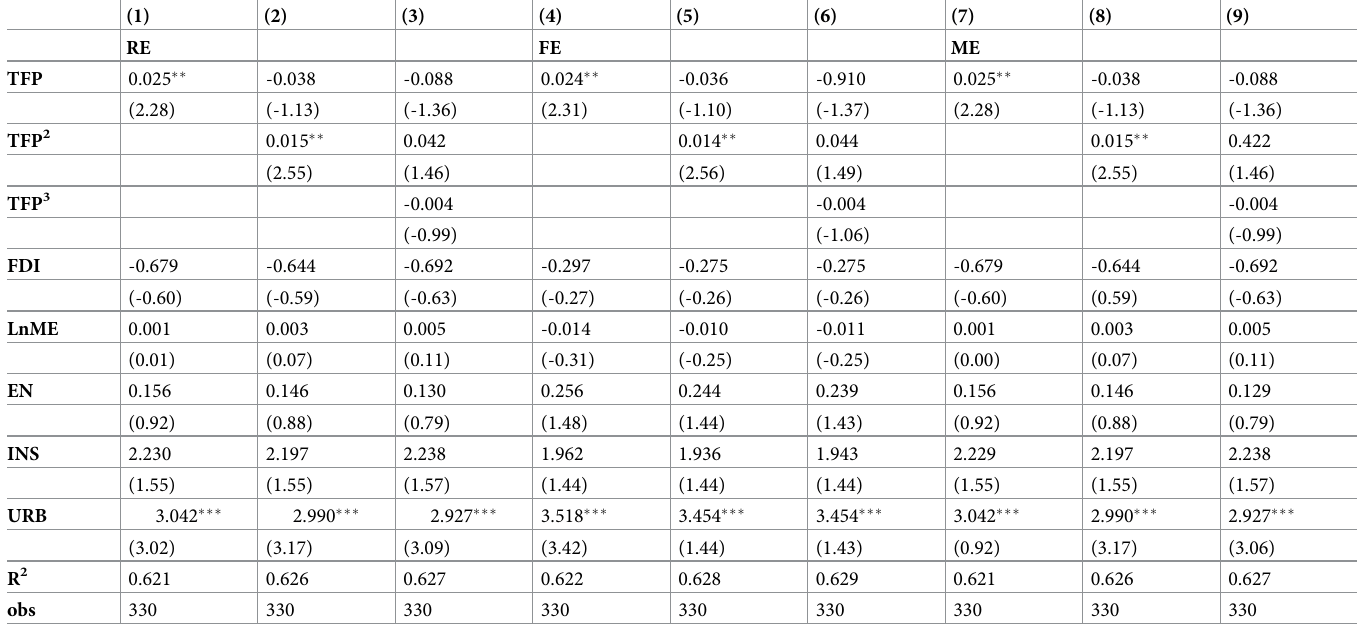
Table 6. Baseline